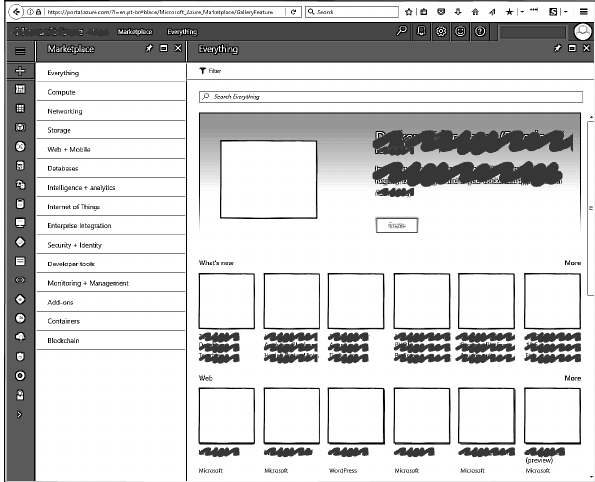
Fig. 15. Microsoft Azure dashboard with a listing of available services and other